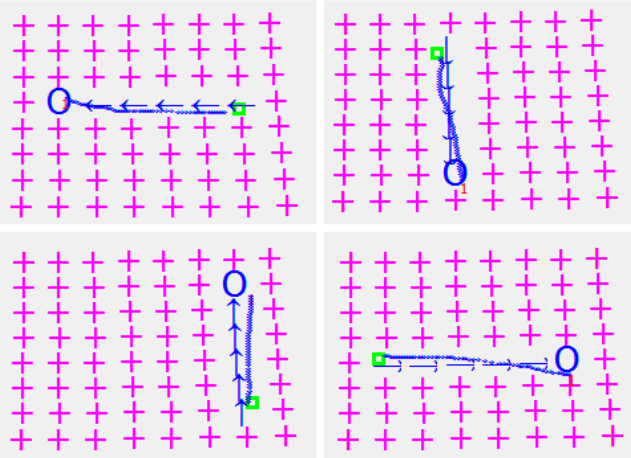
Figure 18. µobject conveyed in four different directions and the deviation errors of its desired and obtain positions. The initial object position is shown by a green color “ □ ” symbol; the blue color arrows show the conveyance trajectory and direction; the blue color symbol “O” indicates the nearest hole from the final object position; the blue color line presents the real trajectory of the object.